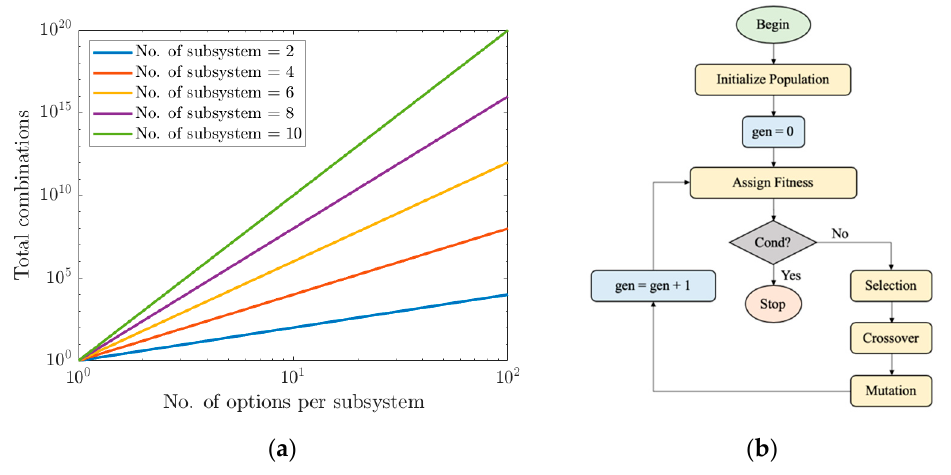
Figure 2. ( a ) Possible design combinations for varying number of components and options; ( b ) evolutionary algorithm structure [27].